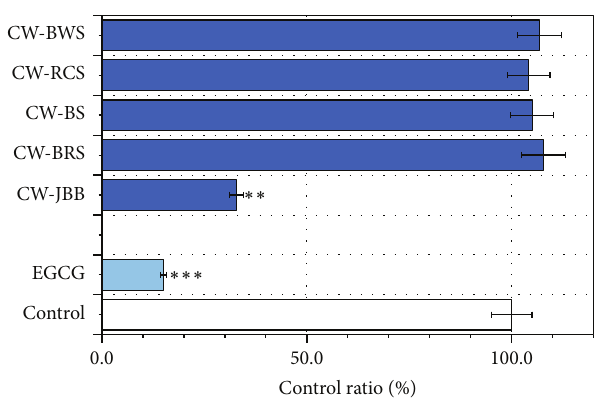
plant sprouts’ aqueous extracts (PSAE). BSA (final concentration 10 mg/mL) in the presence of D-ribose (final concentration 1M) was kept at 37 ∘ C in Tris-HCl buffer (pH 7.4). PSAE was mixed with samples of BSA+D-ribose for up to 24 h. The fluorescence intensity of glycation was recorded ( 𝜆 ex 360 nm; 𝜆 em 465nm). BSA (or LAB) and D-ribose were used as a control. Aliquots were taken for measurements of fluorescence spectra ( 𝜆 ex = 360 nm). Values are mean ± SD of the three measurements. ∗∗∗ 𝑃 < 0.001 and ∗∗ 𝑃 < 0.01 compared with the controls.